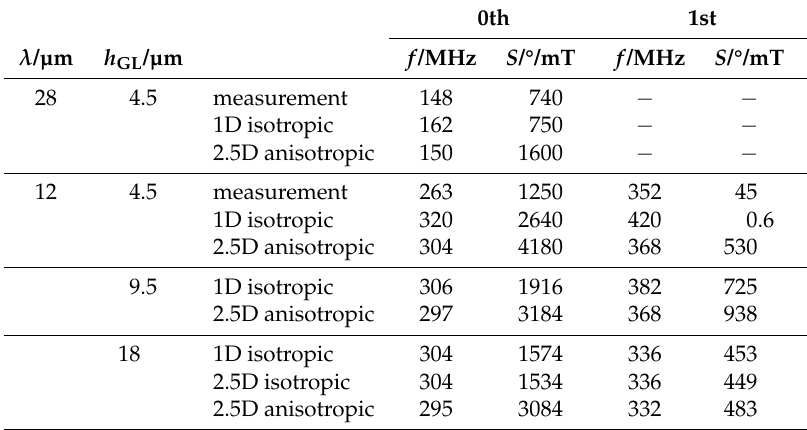
Table 2. Comparison of the measured and simulated sensitivities for different wavelengths λ and guiding layer thicknesses h GL